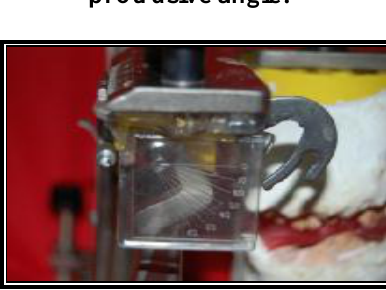
Figure 7 a: Estimation of the protrusive angle.